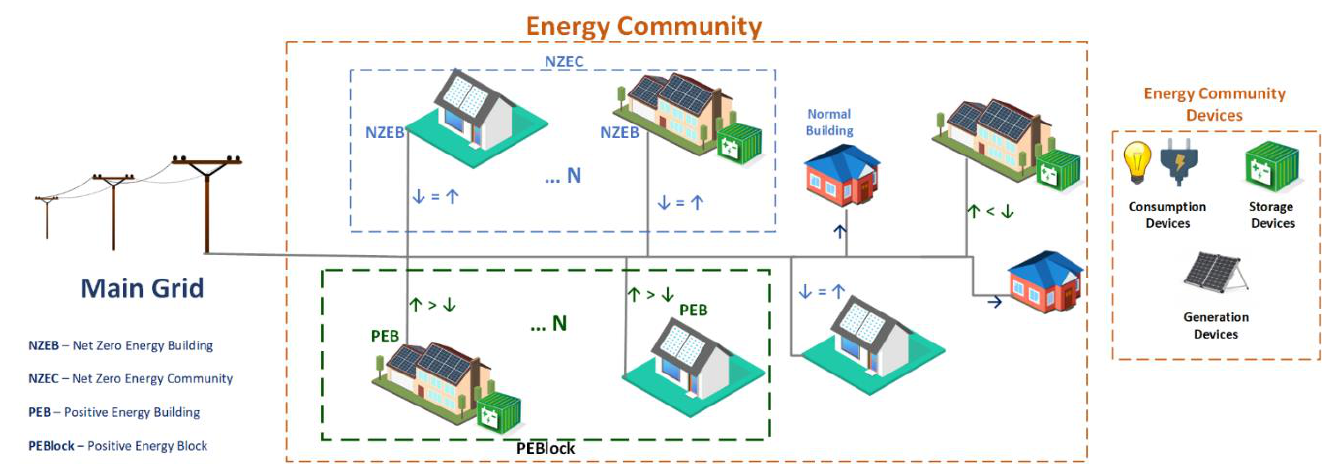
Figure 3. General Architecture of an energy community.